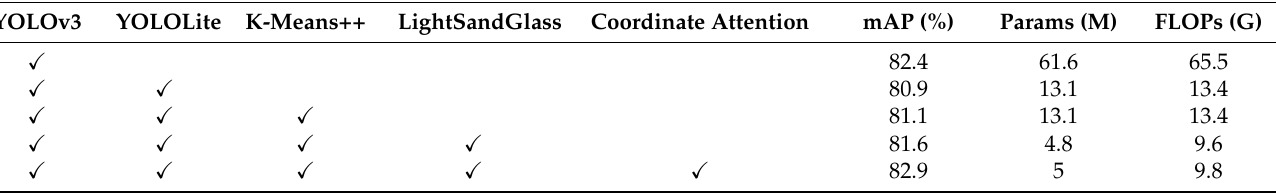
Table 4. The results of the ablation experiment for the proposed improved methods.